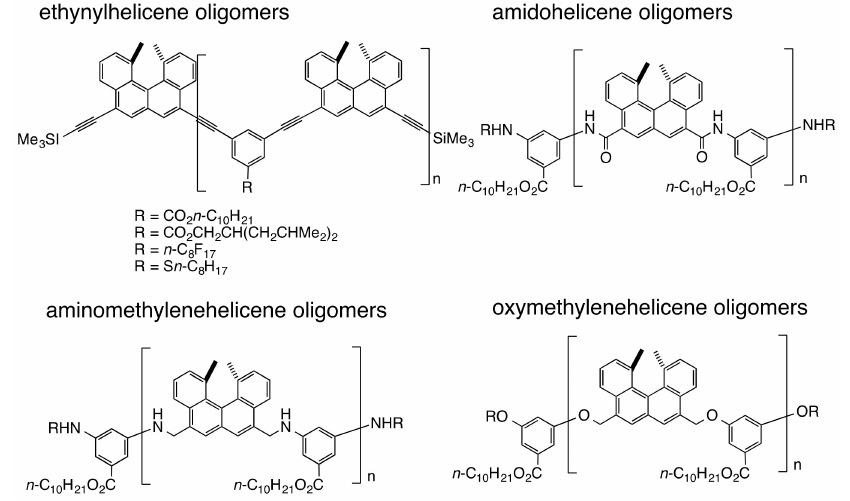
Figure 12. Chemical structures of acyclic helicene